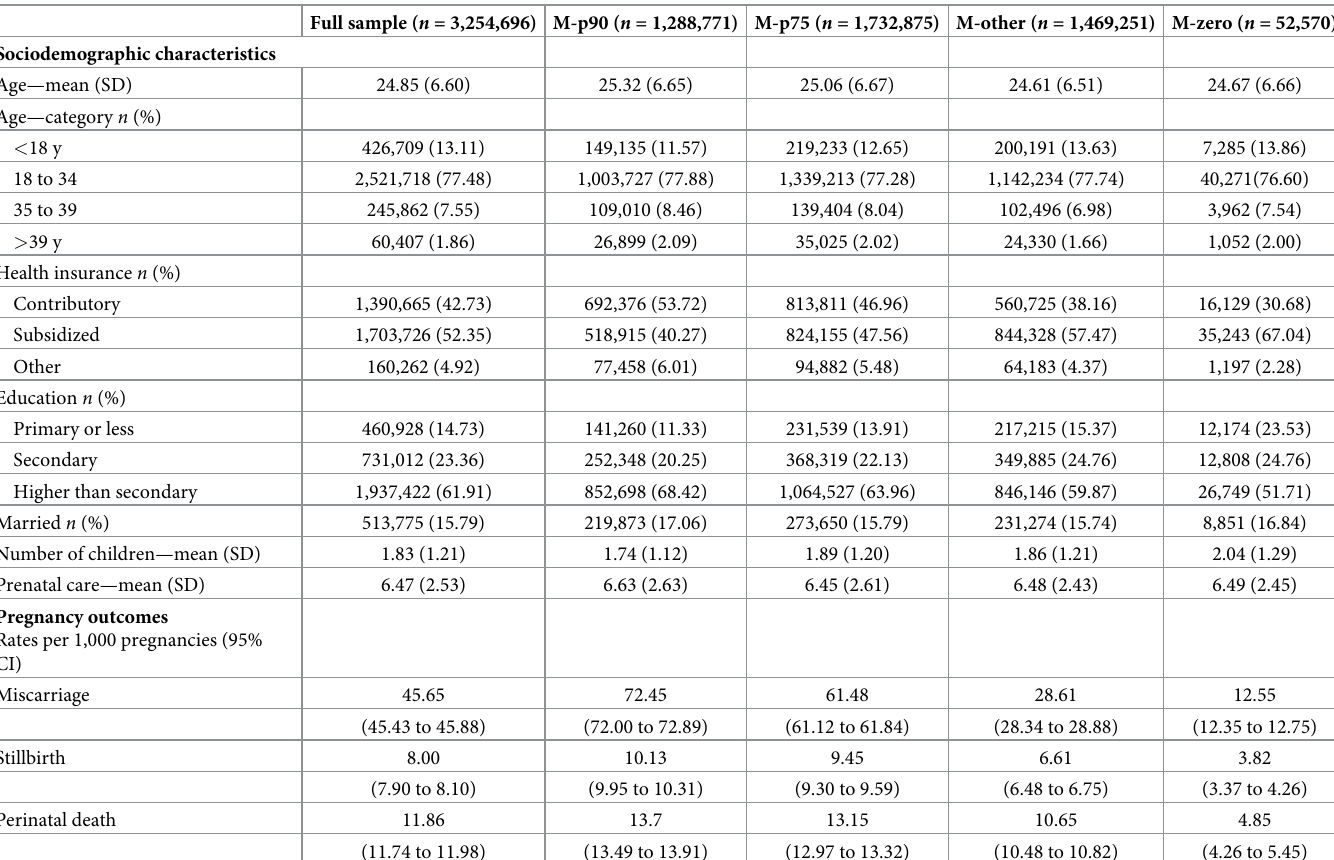
Table 1. Baseline characteristics of all pregnant women in Colombia between January 1, 2013 and December 31,